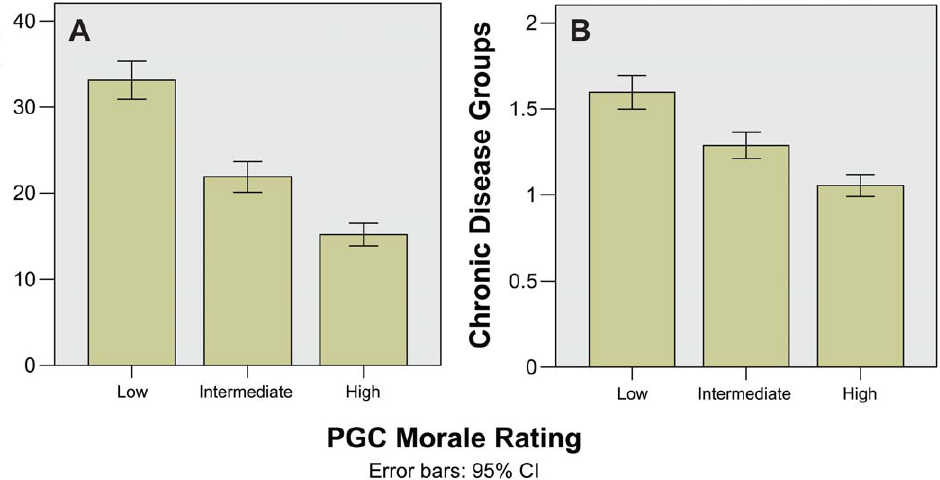
Figure 2. Bar charts showing chronic illness disability against PGC morale rating. A) mean WHODAS-II scores, and B) total number of chronic disease groups.